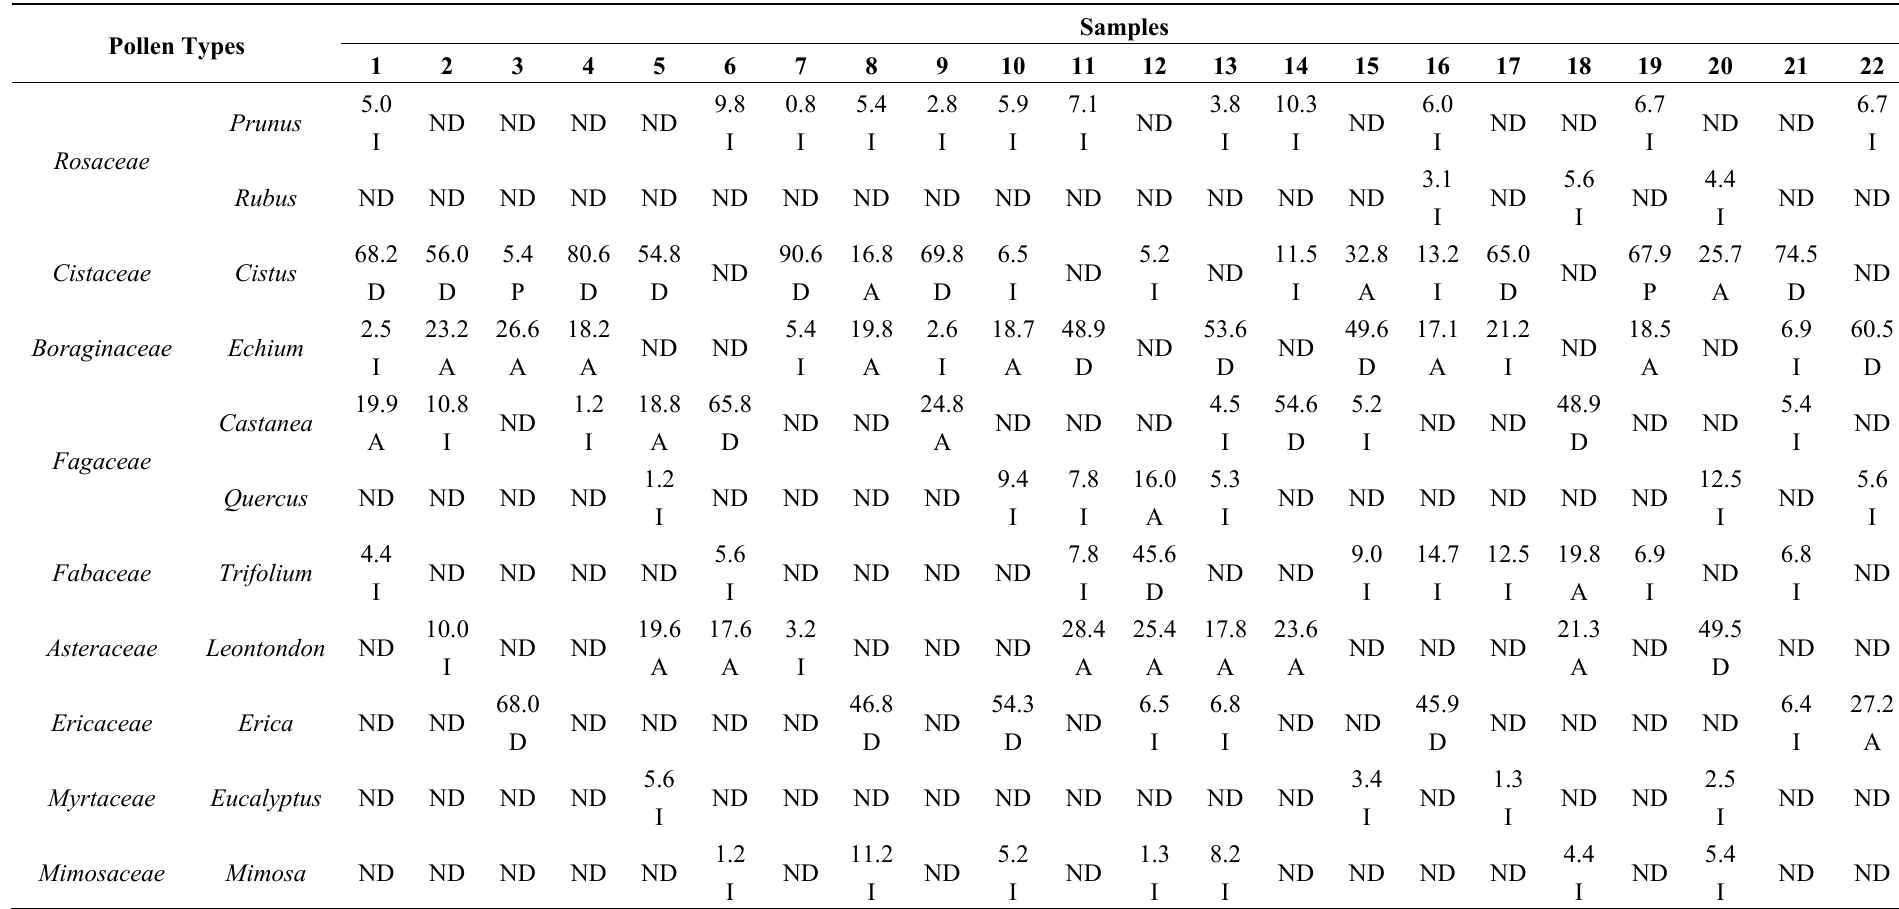
Table 2. Palynological spectrum of the total organic apian